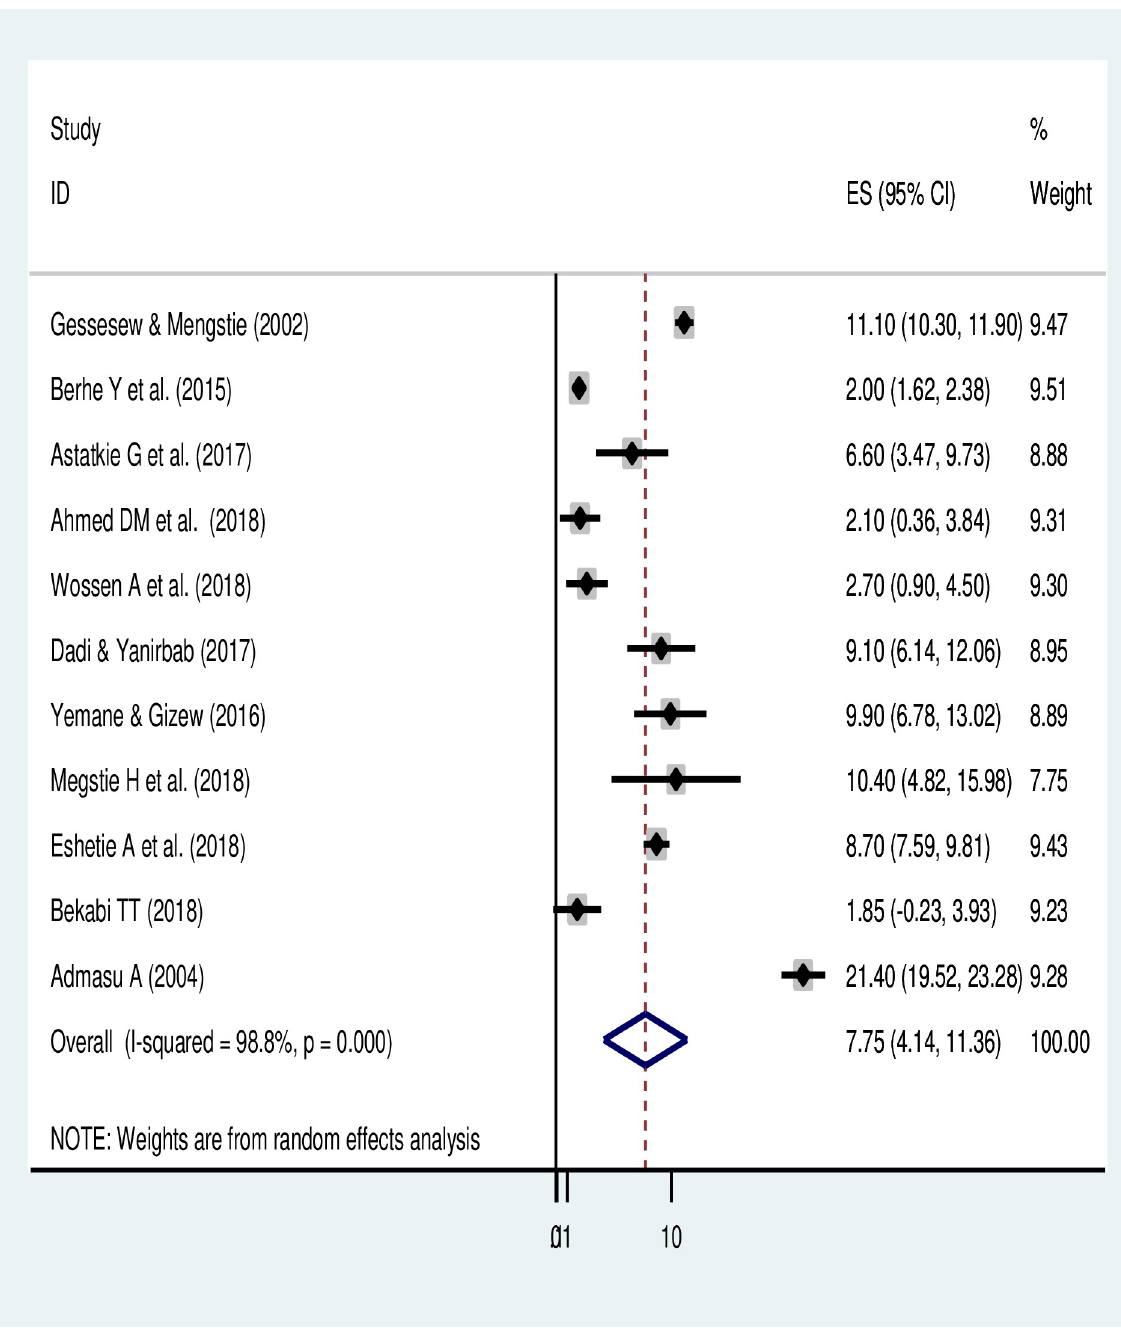
Fig 2. Pooled maternal mortality of uterine rupture in